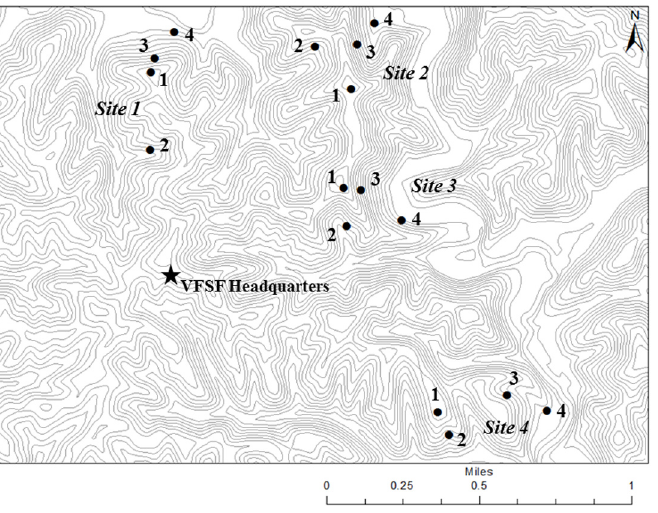
Fig 2. Common garden locations. Common gardens were allocated to ridge tops (1), south benches (2), northeast benches (3), and stream terraces (4) at four sites within the Vinton Furnace Experimental Forest in the Ohio Hills. Lines of equal elevation are at 20 meter